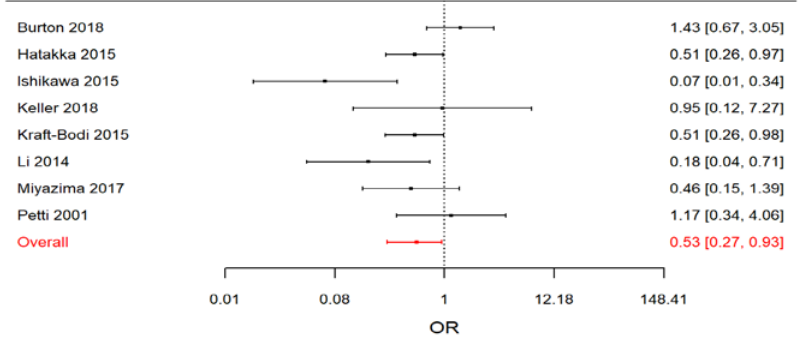
Figure 5. Forest plot from the Bayesian random-effects meta-analysis on randomized controlled studies.